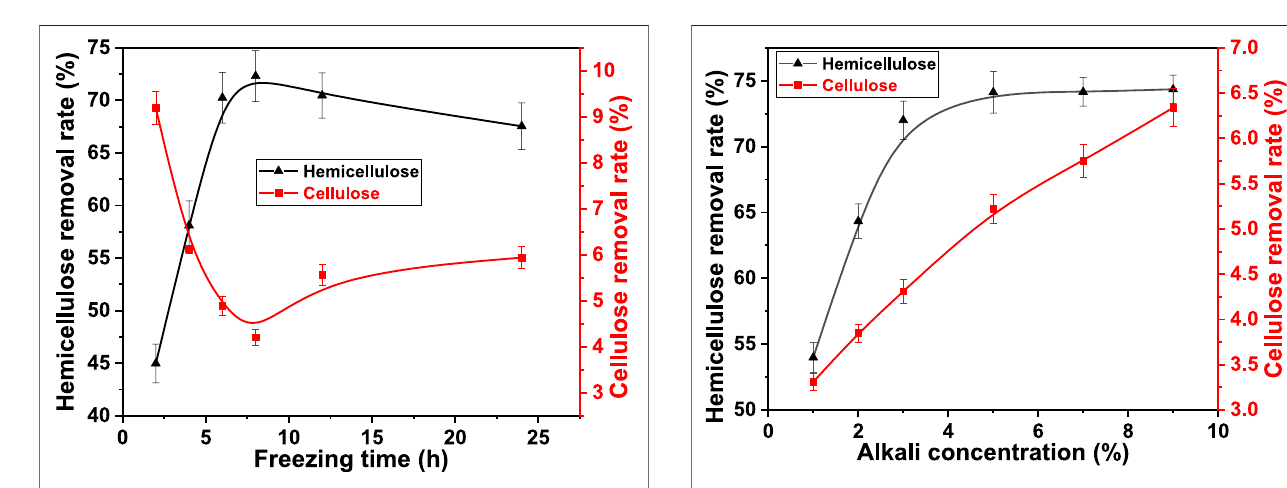
FIGURE 2 | Effect of freezing time on the removal rate of cellulose and hemicellulose from bagasse fi ber in FT/AT.